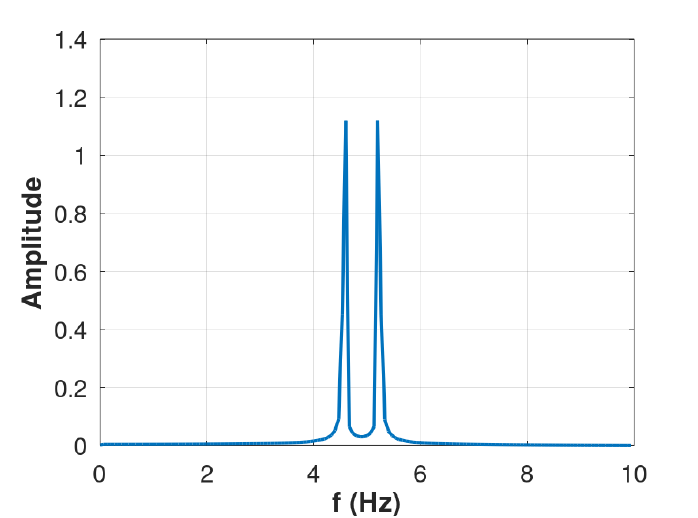
Figure 5. Parkinson’s tremor signal in the frequency